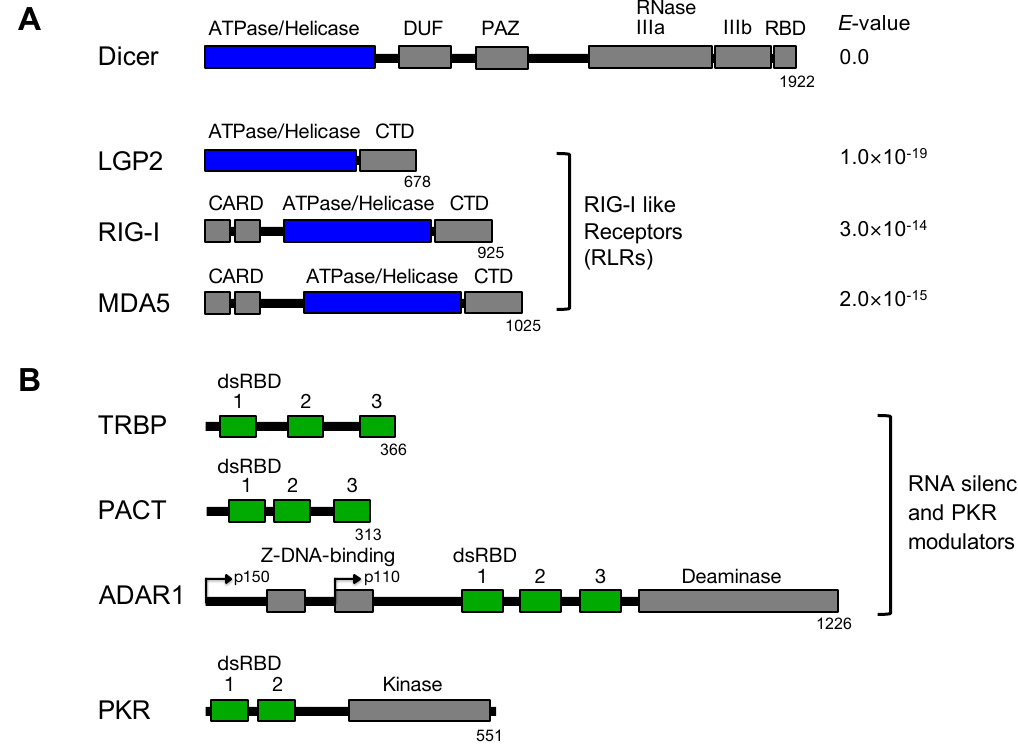
Figure 3. Domain structures of Dicer, RLRs, trans-activation response (TAR) RNA-binding